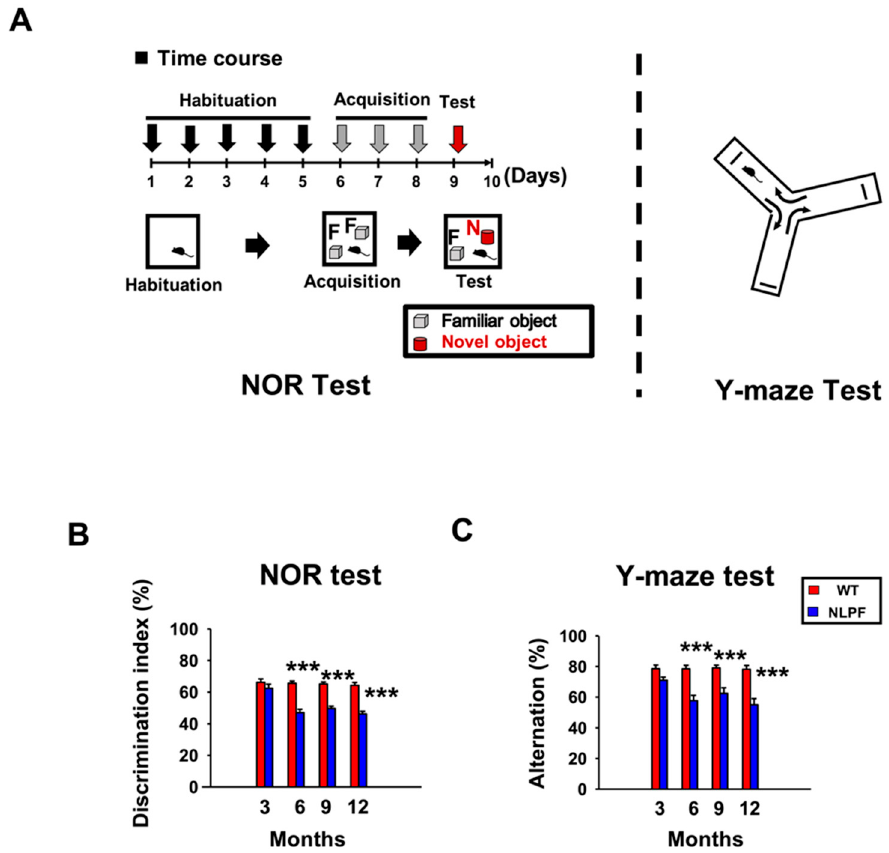
Figure 3. Cognitive function of APP NL-P-F/NL-P-F mice from three to twelve. ( A ) Time course and diagram of the behavioral test. ( B ) Discrimination index of novel object recognition (NOR) test. ( C ) Spontaneous alternation (%) of Y-maze test. WT ( n = 10–15), NLPF ( n = 10–15). The values indicate the mean ± SEM. *** p < 0.001, compared with age-matched WT.